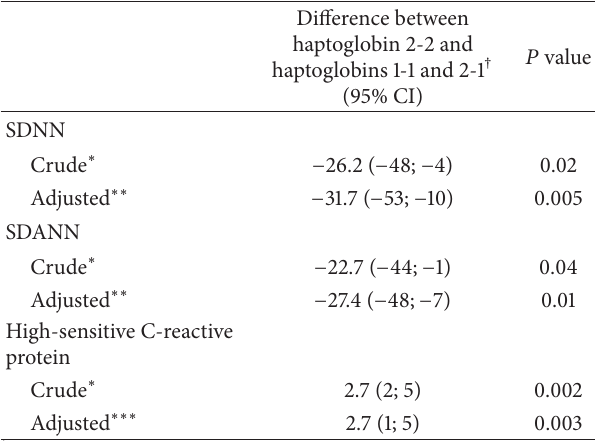
Table 2: Differences in SDNN, SDANN, and high-sensitive C- reactive protein between patients with haptoglobin genotype 2-2 compared to patients with haptoglobin genotypes 1-1 and